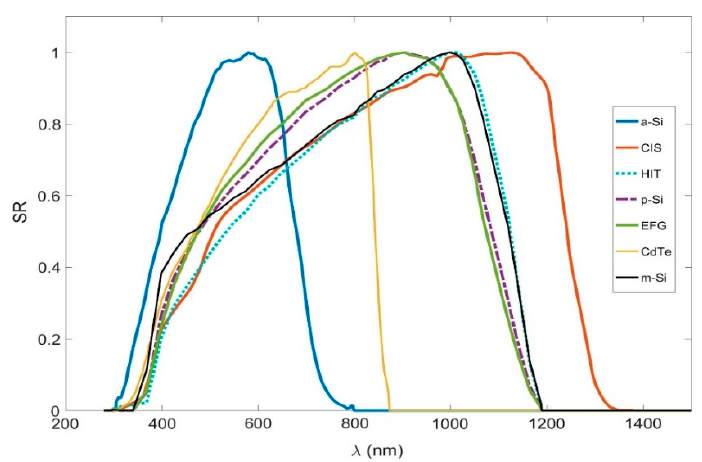
Figure 2. Spectral response for various technologies [6].